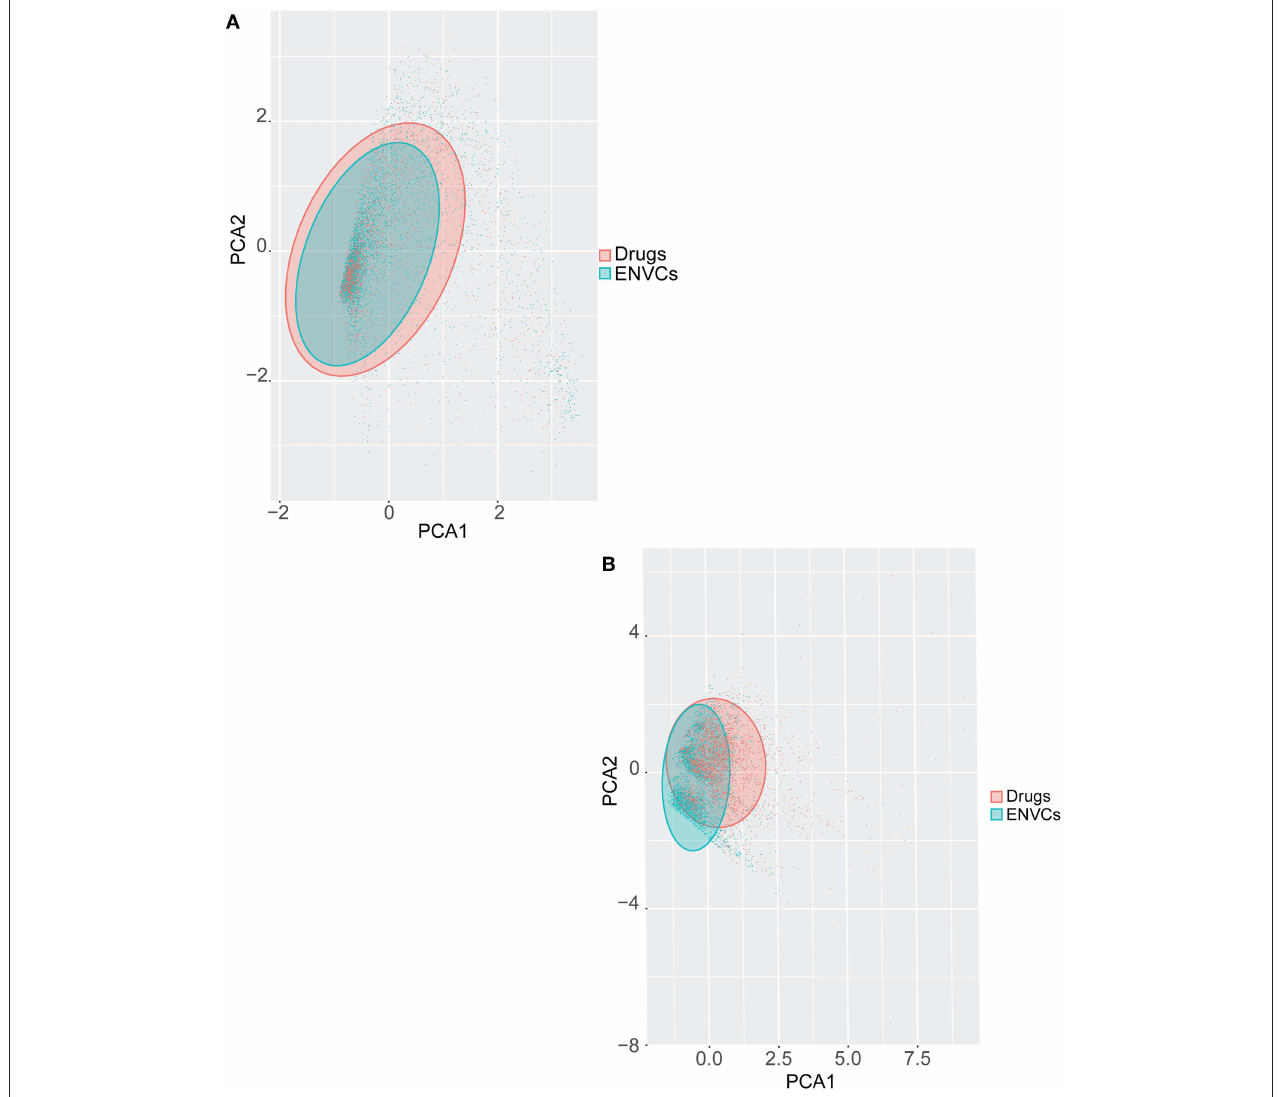
FIGURE 6 | PCA of drugs and ENVCs using (A) Tox21 assay activity profiles, and (B) chemical structure data. The shaded area captures 95% of variance in